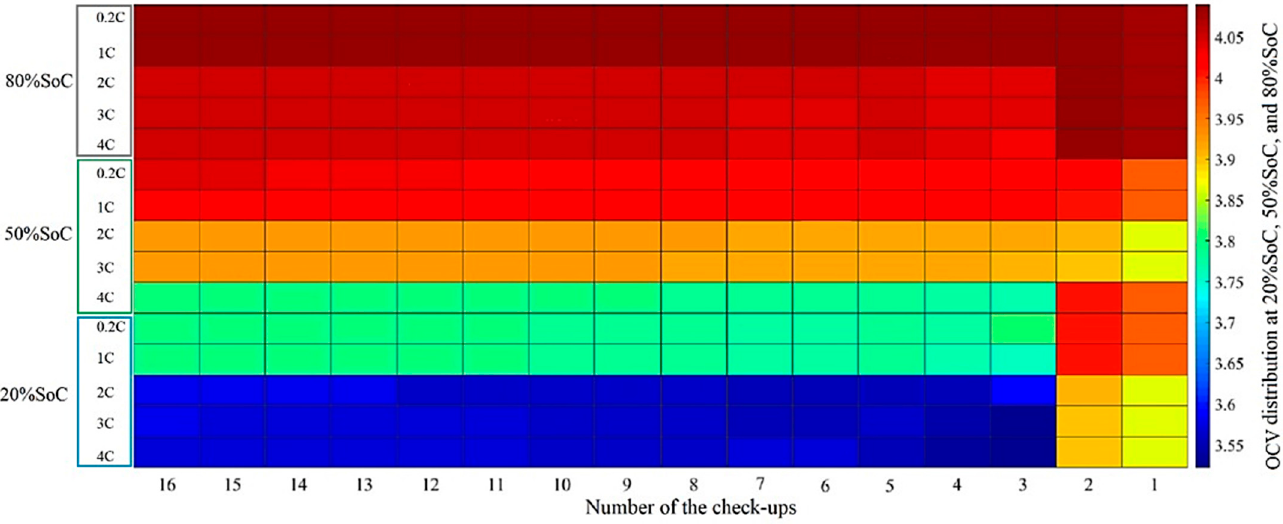
Figure 14. OCV distribution at different SoC percentages at 25 °C under different test conditions.